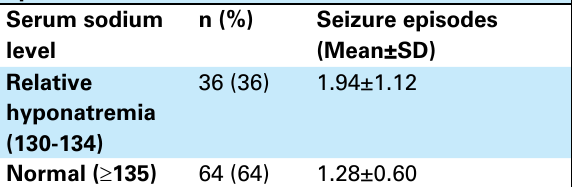
Table 2. Serum sodium level, and mean seizure episodes (n=